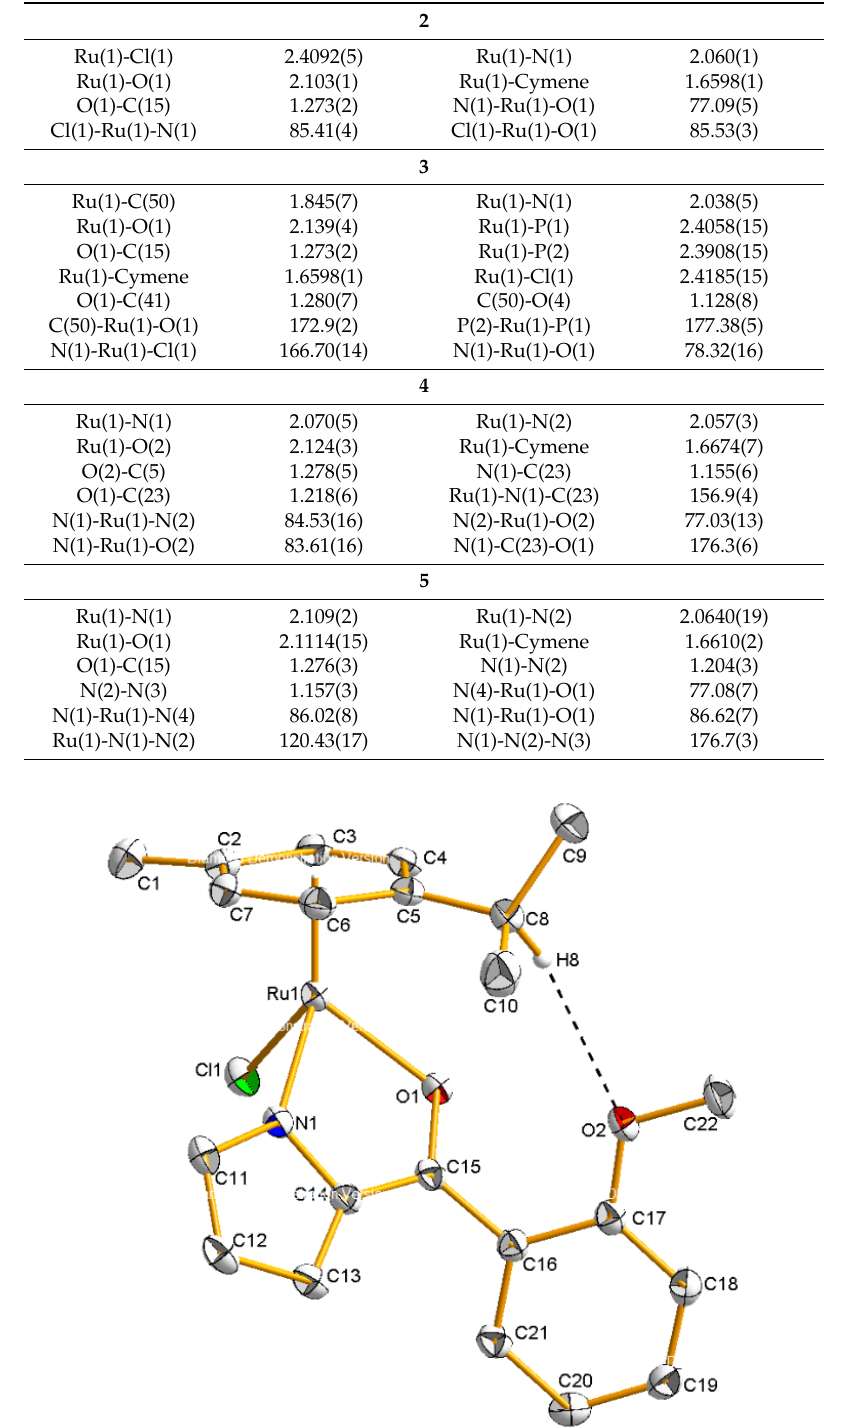
Figure 1. The molecular geometry of Compound 2 . The thermal ellipsoids were drawn at 50% probability and all the hydrogen atoms except the methine proton on the cymene ring were omitted for clarity. The H8-O2 hydrogen bonding is shown.